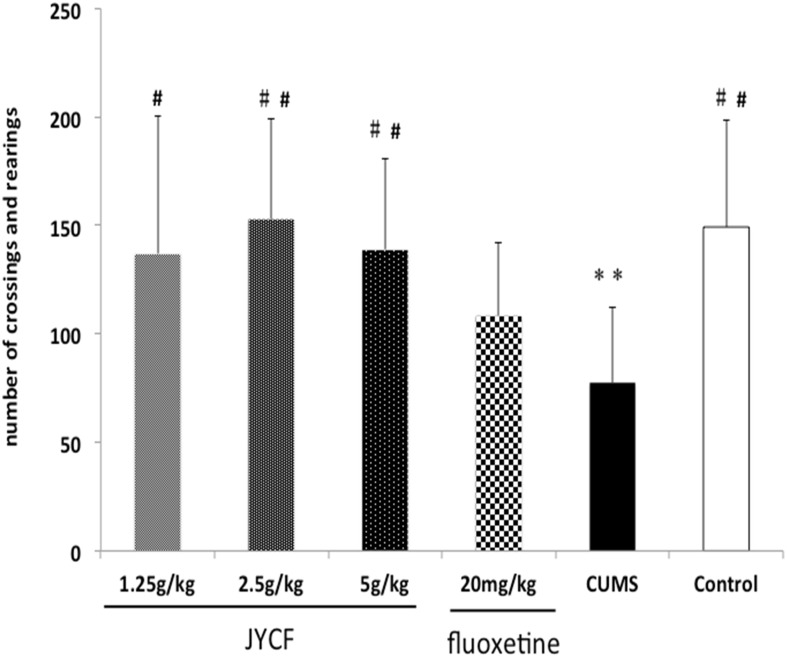
Effect of JYCF and fluoxetine on the number of crossings and rearings in the open-field test.A one-way ANOVA demonstrated a significant reduction in number of crossings and rearing in comparison to the normal control group [F (5, 42) = 3.323, P < 0.05] after 5-week CUMS exposure. Post hoc testing showed that JYCF (1.25 g/kg, 2.5 g/kg, and 5 g/kg) improved the number of crossings and rearings significanctly (P < 0.05, P < 0.01, and P < 0.01 respectively). Results are expressed as mean ± S.E.M. (n = 8 each). **P < 0.01, as compared with the control group; #P < 0.05, ##P < 0.01, as compared with the CUMS group.